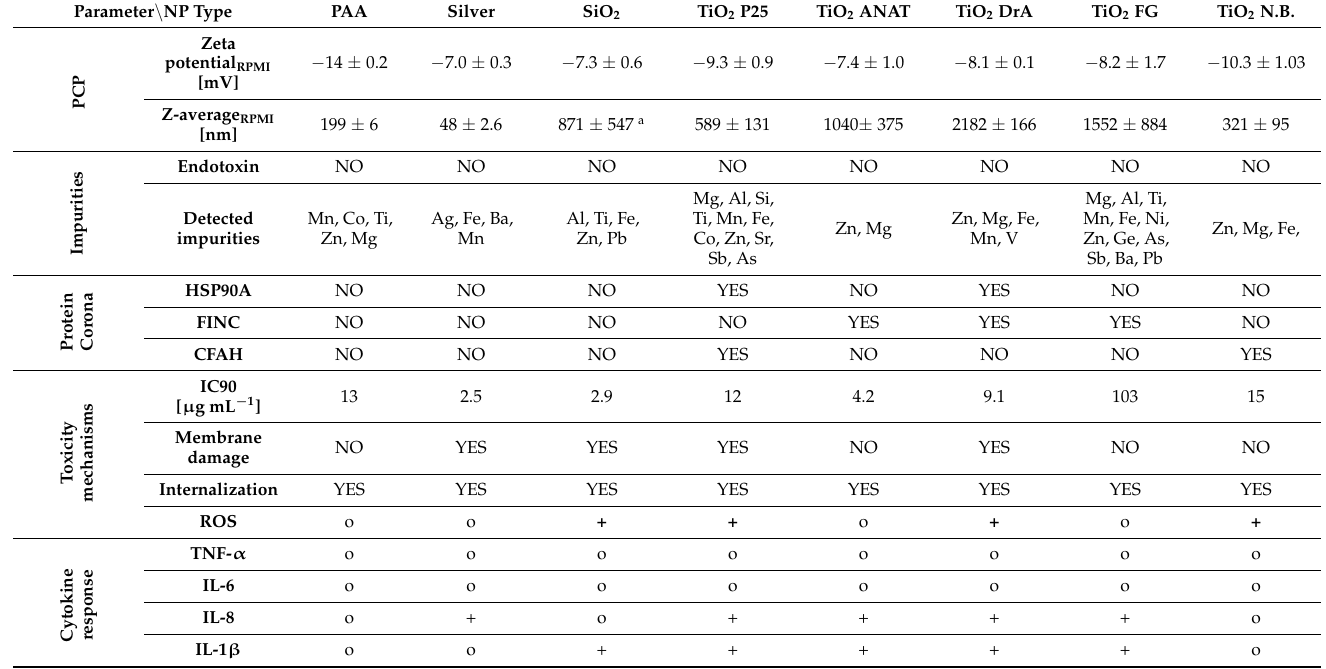
Table 1. Overview of the NPs PCP, corona proteins (involved in the immune response) and the cell responses to NP